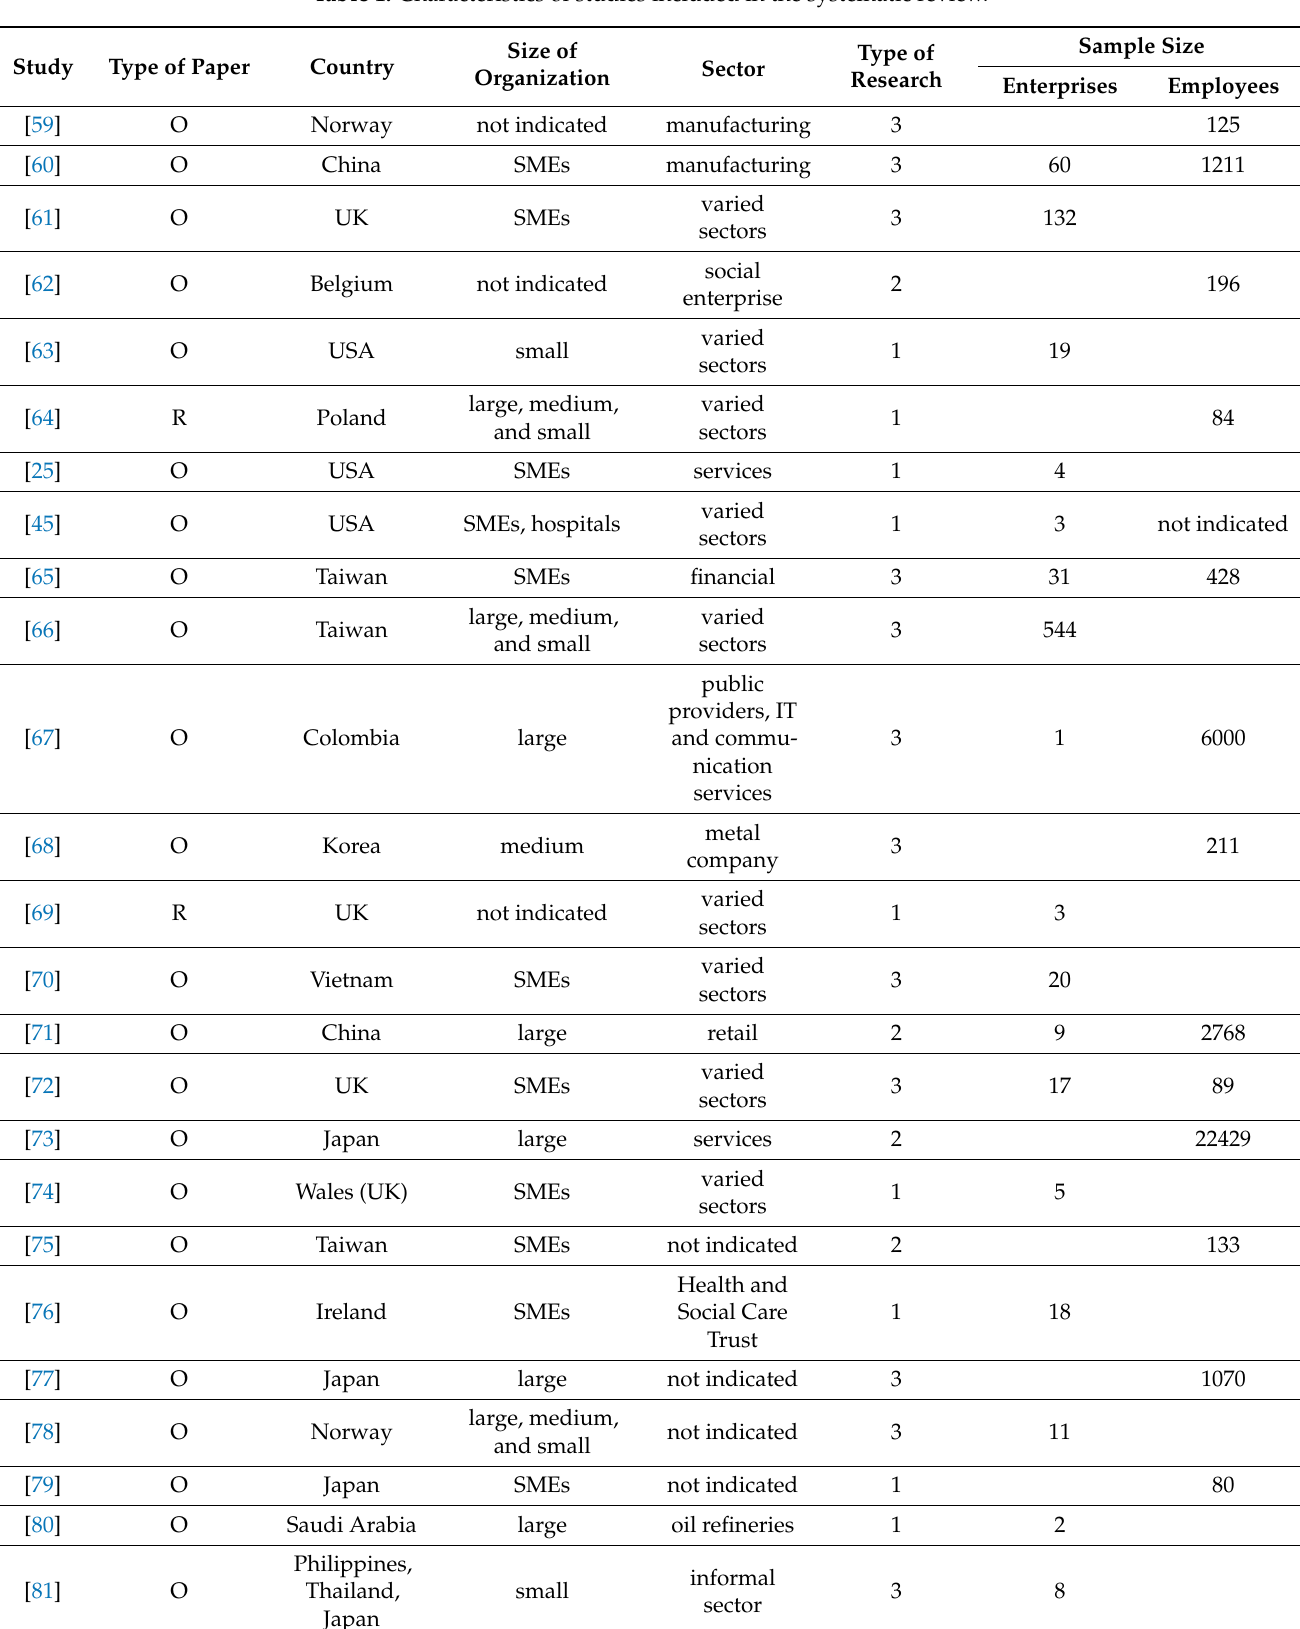
Table 1. Characteristics of studies included in the systematic